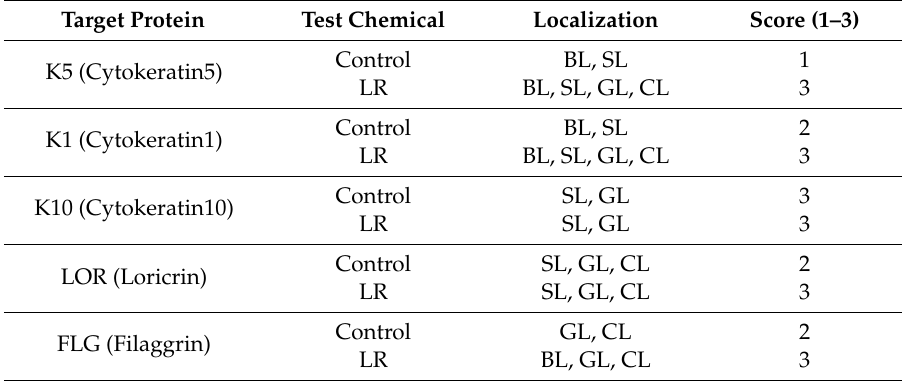
Figure 3. Immunohistochemical and immunofluorescence images of Keraskin TM treated with LR lysate. ( a ) Immunohistochemical images of Keraskin TM with antibodies against cytokeratin 5 (K5), 1 (K1), 10 (K10), loricrin (LOR) and filaggrin (FLG). LR lysate was topically applied to Keraskin TM every other day for 16 days. ( b ) Immunofluorescence images of Keraskin TM . DAPI (blue) was used for nuclear staining and red fluorescent indicated lineage markers. Table 1. The localization and intensity score of immunohistochemistry analysis of epidermal differentiation markers.